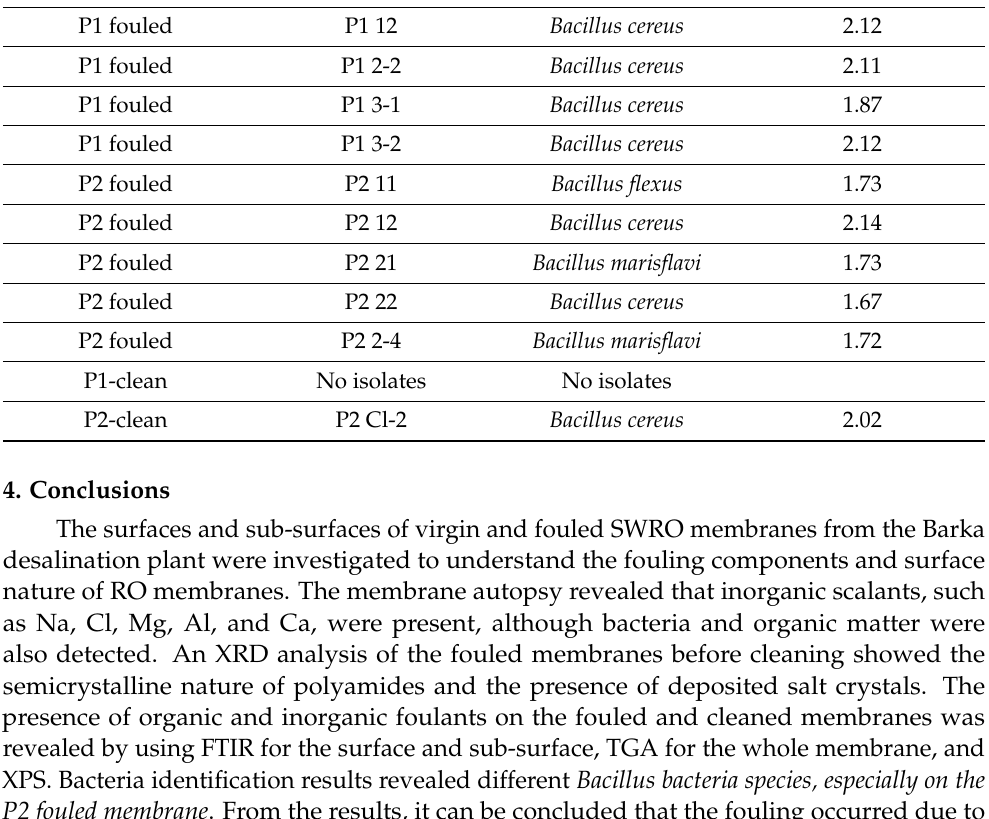
Figure S3: SEM-EDX analysis of virgin sea water membrane; Figure S4: SEM-EDX analysis of some deposits attached on the P1-clean surface (a) spectrum 8 and (b) spectrum 9; Figure S5; SEM-EDX analysis of some deposits attached on the P2-clean surface (a) spectrum 18 and (b) spectrum